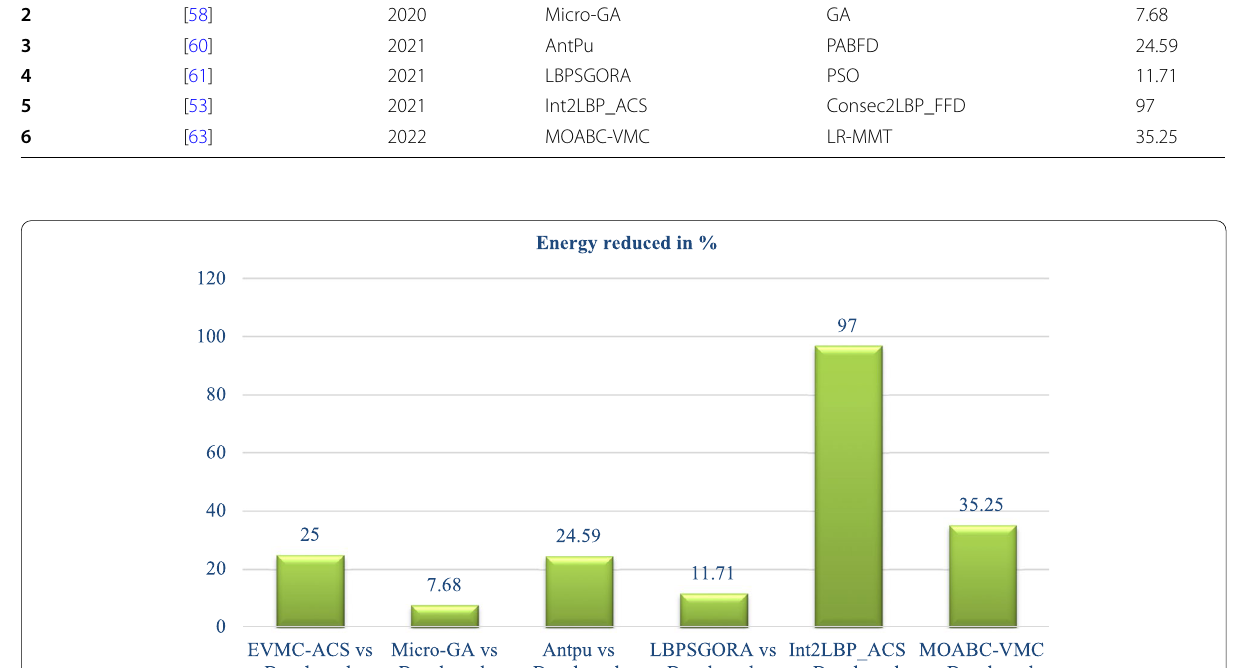
Fig. 11 Energy reduction in Metaheuristic techniques vs